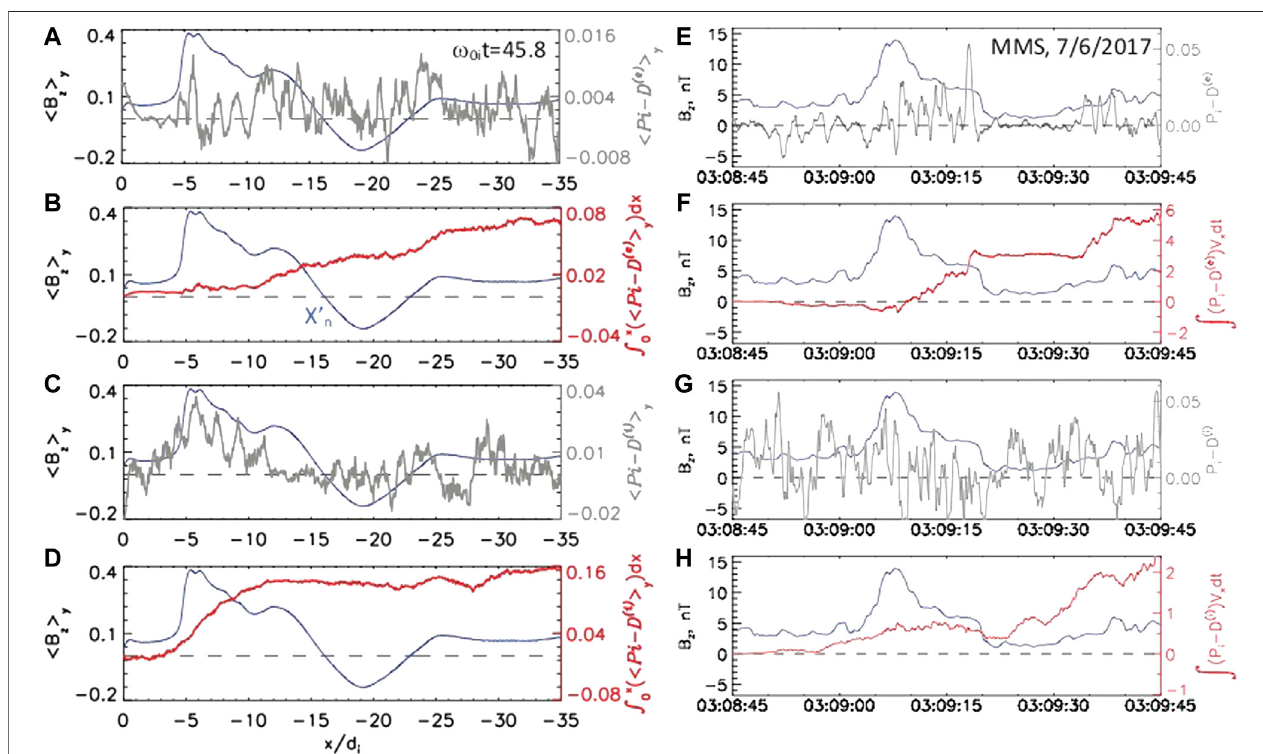
FIGURE 14 | (A – D) Kinetic dissipation parameters in the unsteady reconnection region in PIC simulations ( Figure 13 ) and (E – F) similar parameters derived from MMS observations ofaDFon6July2017 at ( x , y , z ) (cid:1) (− 19 , 3 , 3 ) R E .Fromtoptobottomthepanelsshowthepro fi les ofaverages 〈 ... 〉 y overthe y direction0 < y < 5 d i 〈 Pi − D ( e ) 〉 for (A) the electron dissipation parameter 〈 Pi − D ( e ) 〉 y (gray line), (B) its value integrated in x : (cid:23) x y dx (red line), (C) the ion dissipation parameter 0 〈 Pi − D ( i ) 〉 ω (cid:1) 45 . 8, which is also described in Figures 12E , 13 . In all panels the magnetic (gray line), (D) its value integrated in x : (cid:23) x 0 i t y dx (red line) at the moment 0 fi eld B fi le is shown by blue lines. Panels (G – M) show parameters similar to (A – F) as functions of time in MMS observations in the format z pro